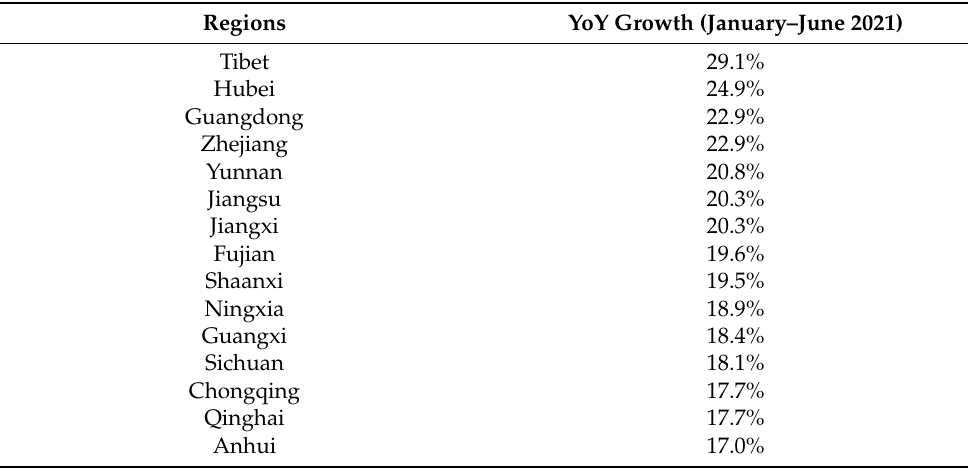
Table 7. Regional growth in electricity consumption from January to June 2021.